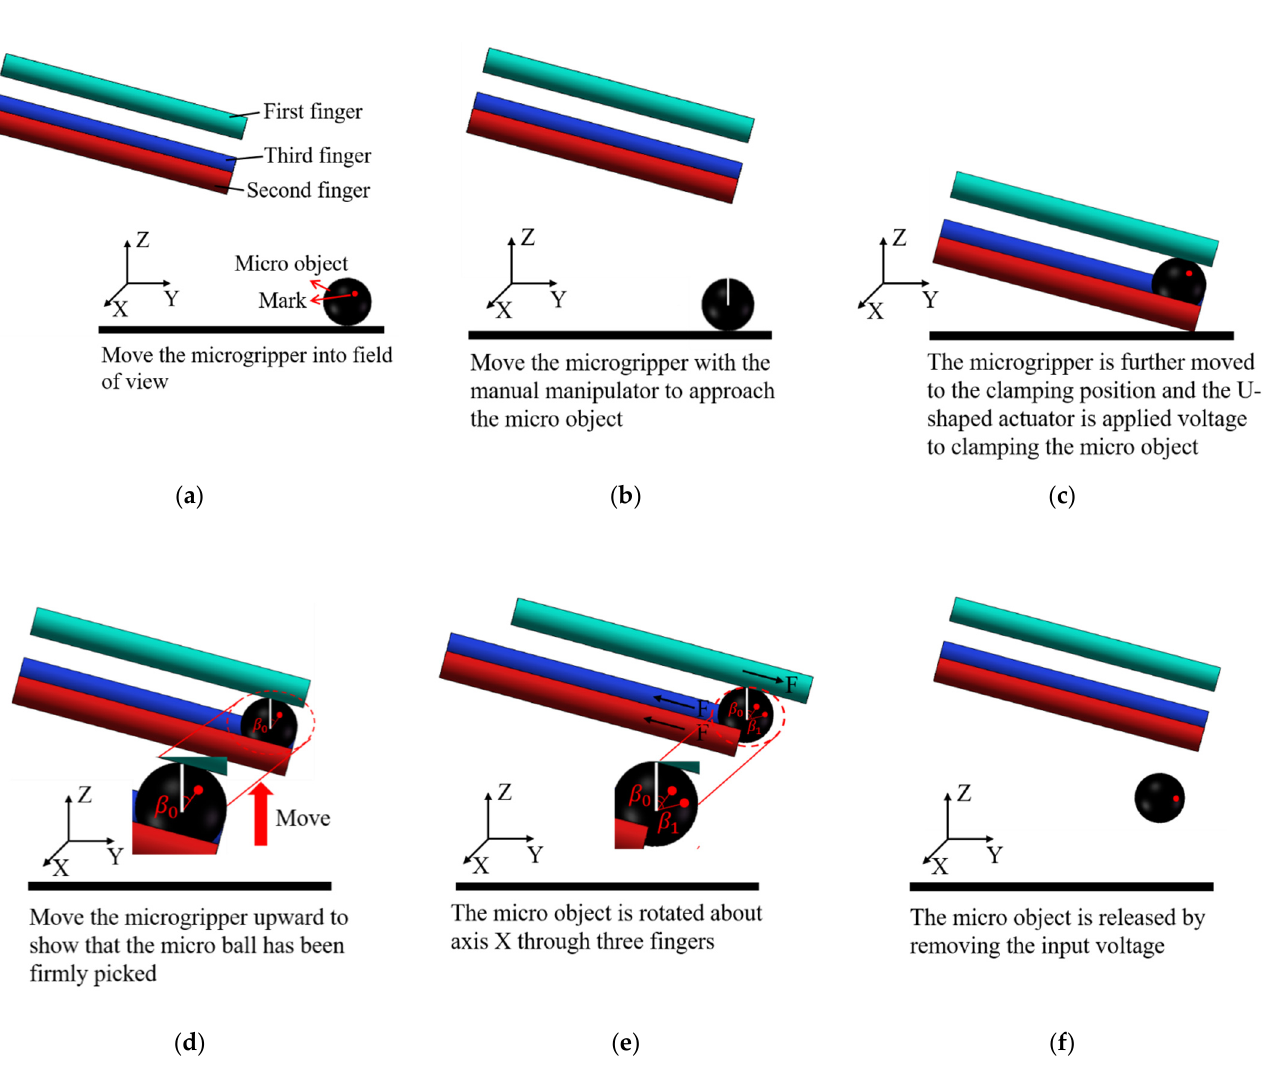
Figure 15. The fabricated 3D microgripper with the Polyimide films.